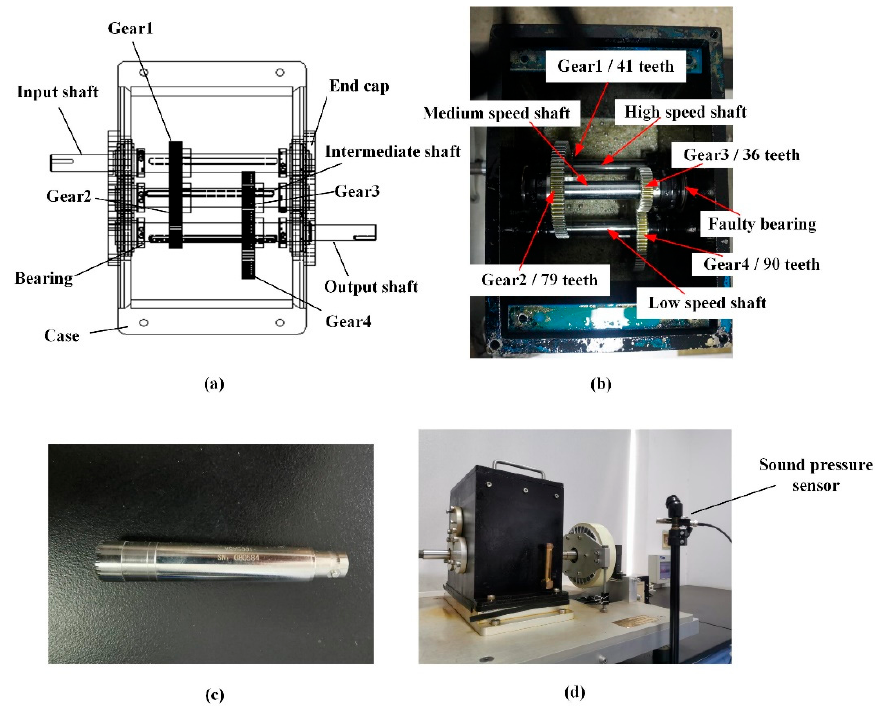
Table 3. Related technical indexes of the sound pressure sensor.